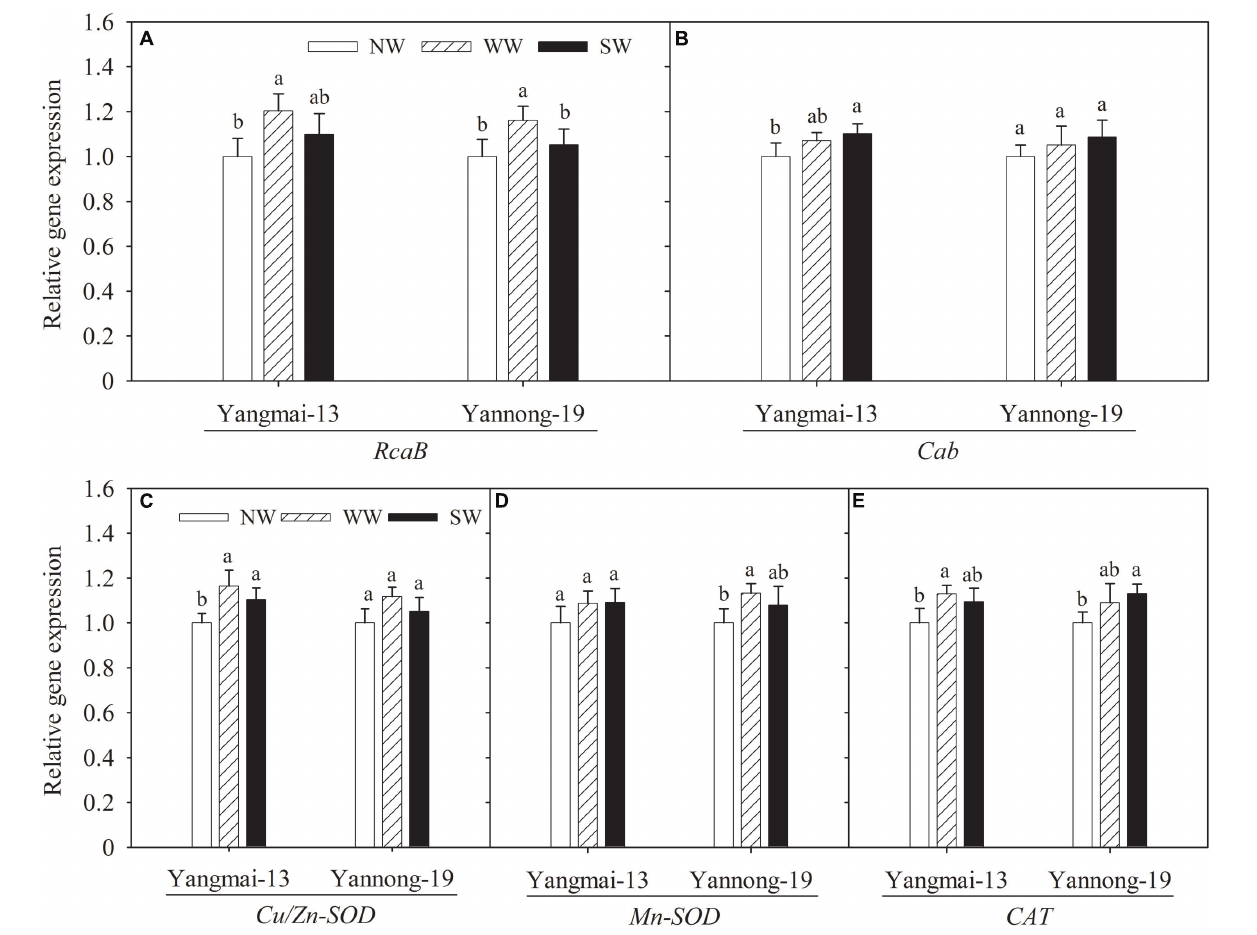
FIGURE 6 | Relative expression of RcaB (A) , Cab (B) , Cu/Zn-SOD (C) , Mn-SOD (D) , and CAT (E) as affected by winter (WW) and spring (SW) night-warming in the flag leaves of Yangmai-13 and Yannong-19 at anthesis during 2013–2014. NW refers to the no warming control. RcaB , encode the Rubisco activase B; Cab , encode the major chlorophyll a/b-binding protein; Cu/Zn-SOD , encode chloroplastic Cu/Zn superoxide dismutase; Mn-SOD , encode the mitochondrial manganese superoxide dismutase; CAT , encode catalase. Lowercase letters refer to significant differences between treatments ( P < 0.05). Whiskers on the top of the bars indicate the standard error ( n =